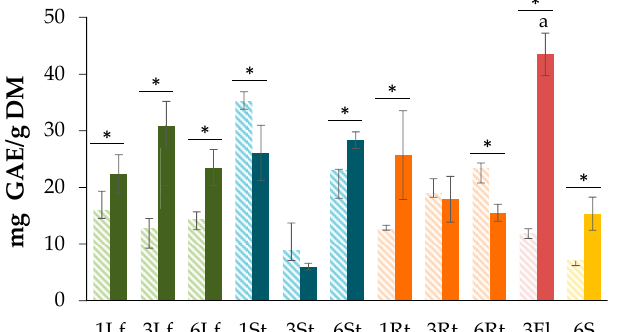
Figure 1. Total phenolic content (TPC) of Chenopodium quinoa processed by air-drying (dash bars) and freeze-drying (dark bars) at di ff erent times after seeding (1, 3, 6 months) of di ff erent plant parts (leaves (Lf), stems (St), roots (Rt), seeds (S), and flowers (Fl)). Each bar represents the mean ± standard deviation ( n = 3). Significant di ff erences between plant parts ( p = 0.00432 < 0.01) were found. Letters represent significant di ff erences between treatments analyzed by the Tukey test ( p < 0.05). * p < 0.05 when compared between drying methods.